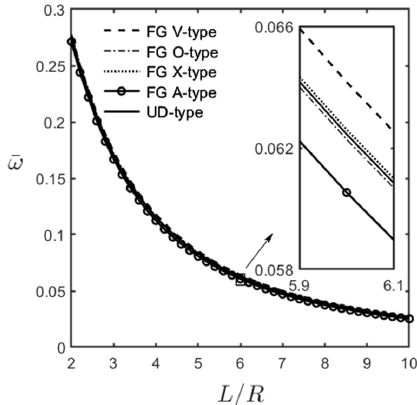
Figure 7. Variations in the dimensionless fundamental frequencies of an FG-GPLRC cylindrical microshell with the ratio of L / R for different GPL distribution patterns, for which ( ˆ m , ˆ n ) = (1, 1), R / h = 5, ˆ l / h = 1.0, and W ∗ GPL